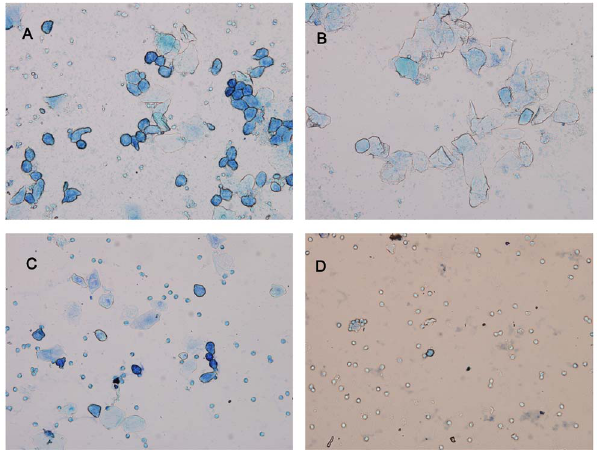
Figure 2. Figures and cell types of vaginal smears. A : preoestrus, loaded mainly with epithelial cell; B : estrus, loaded mainly with keratinocytes; C :metoestrus,displaying epithelial cell, keratinocytes, and leukocytes; D :diestrus, displaying full of leukocytes (magnification 6 100).